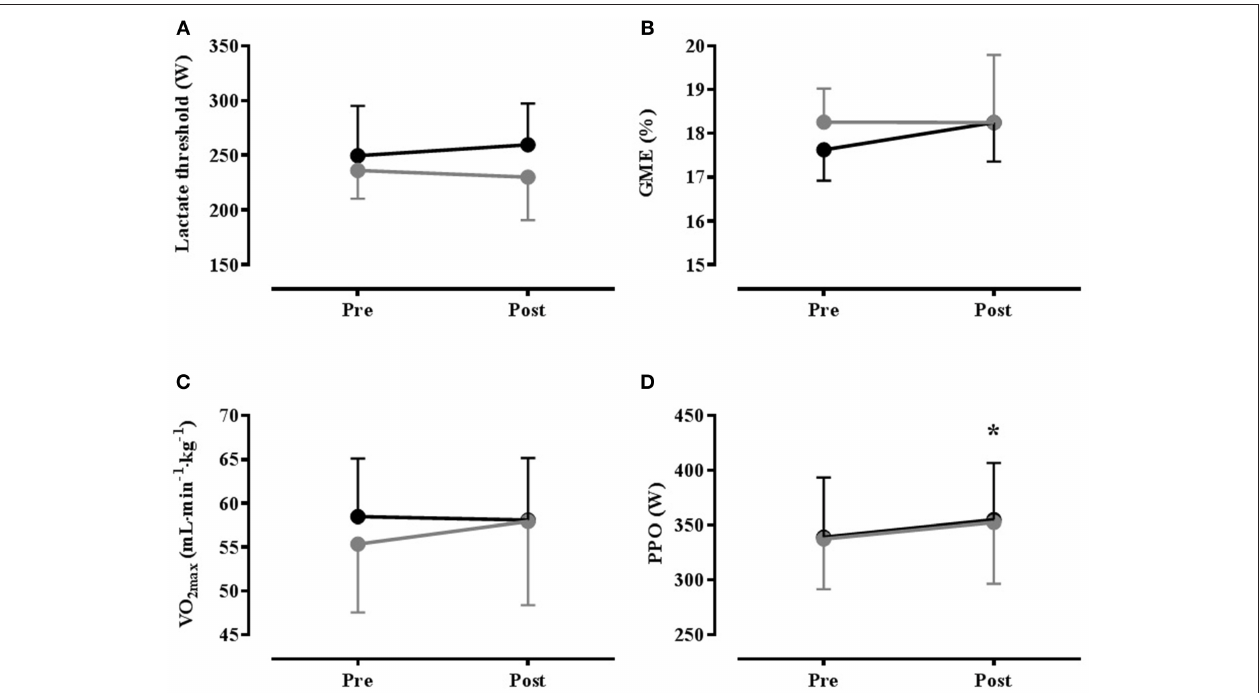
FIGURE 3 | Mean( SD ) results from temperate (22 ◦ C, 55% RH) graded exercise test performed Pre- and Post- heat acclimation, with (HA De : black) and without (HA Eu gray) permissive dehydration ( n = 8). (A) Lactate Threshold; (B) Gross Mechanical Efficiency (GME); (C) Maximal Oxygen Uptake (VO 2max ); (D) Peak Power Output (PPO). * = Significant main effect for time ( P <